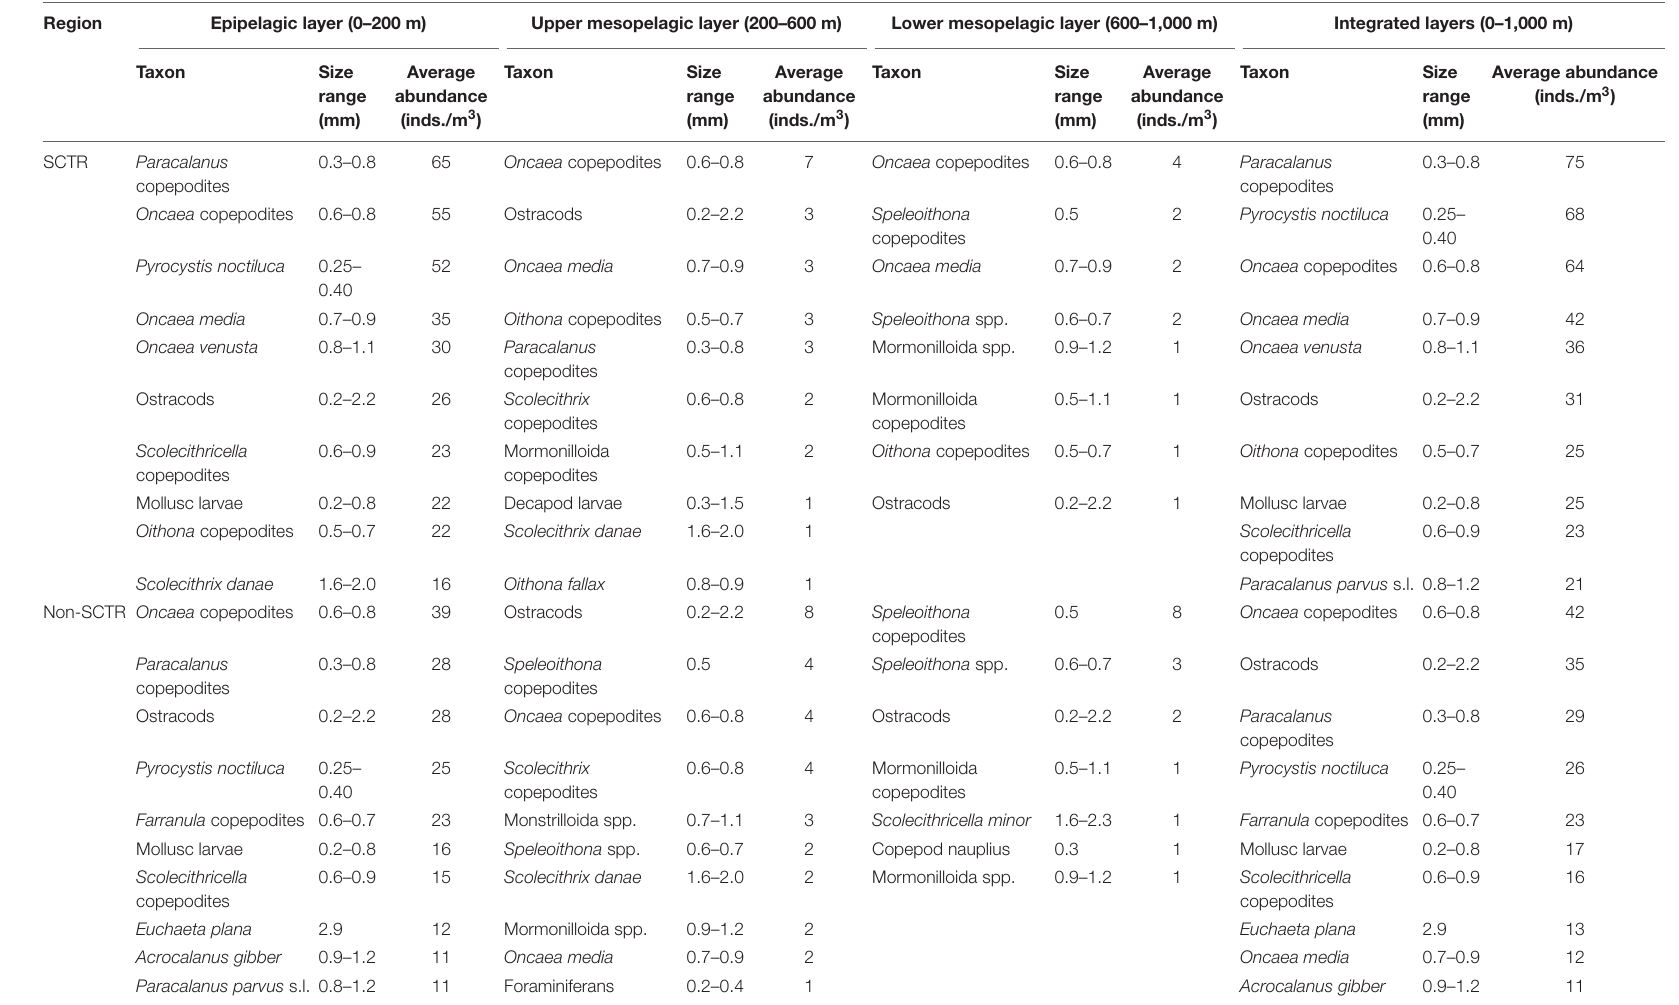
TABLE 5 | Average abundance (inds./m 3 ) and size range (mm) of top 10 numerical dominant zooplankton listed in decreasing order for each depth layer (epipelagic, upper mesopelagic, and lower mesopelagic) and integrated depth layers in the SCTR and non-SCTR